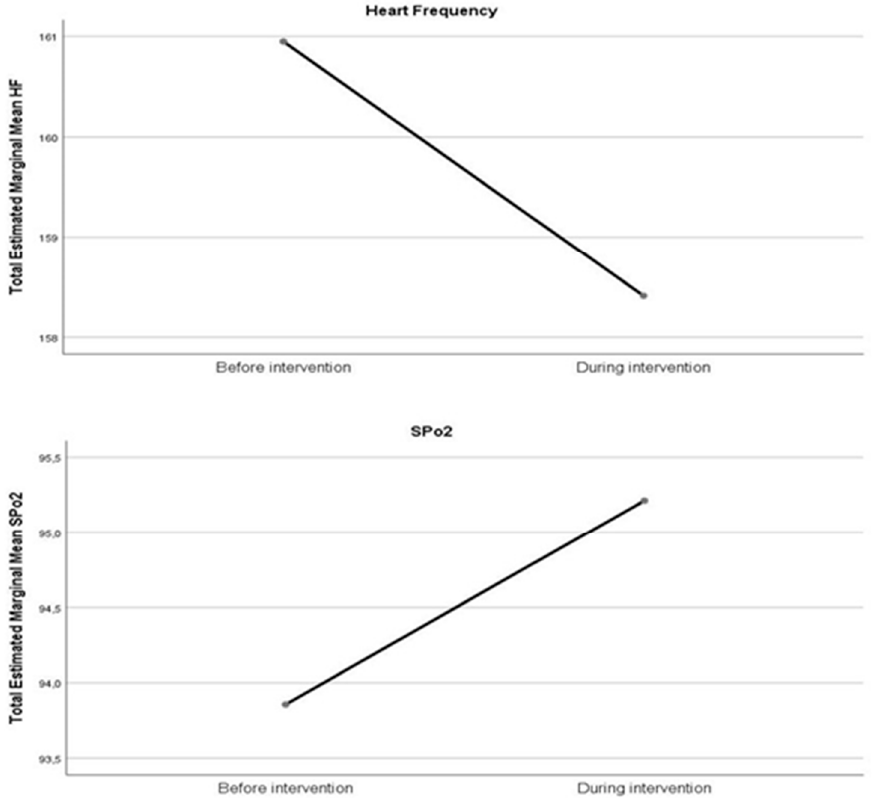
Figure 2. Change in vital signs before and during intervention.